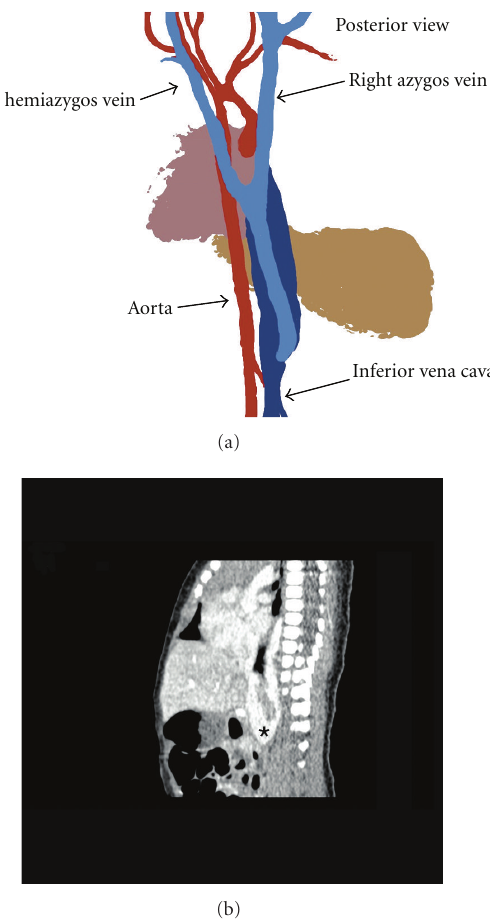
Figure 2: (a) Schematic drawing of azygos vein and hemiazygos vein fusion in the thoracic cavity. The venous duct formed is drain- ing into the IVC. (b) Sagittal CT scan showing venous duct draining into the IVC